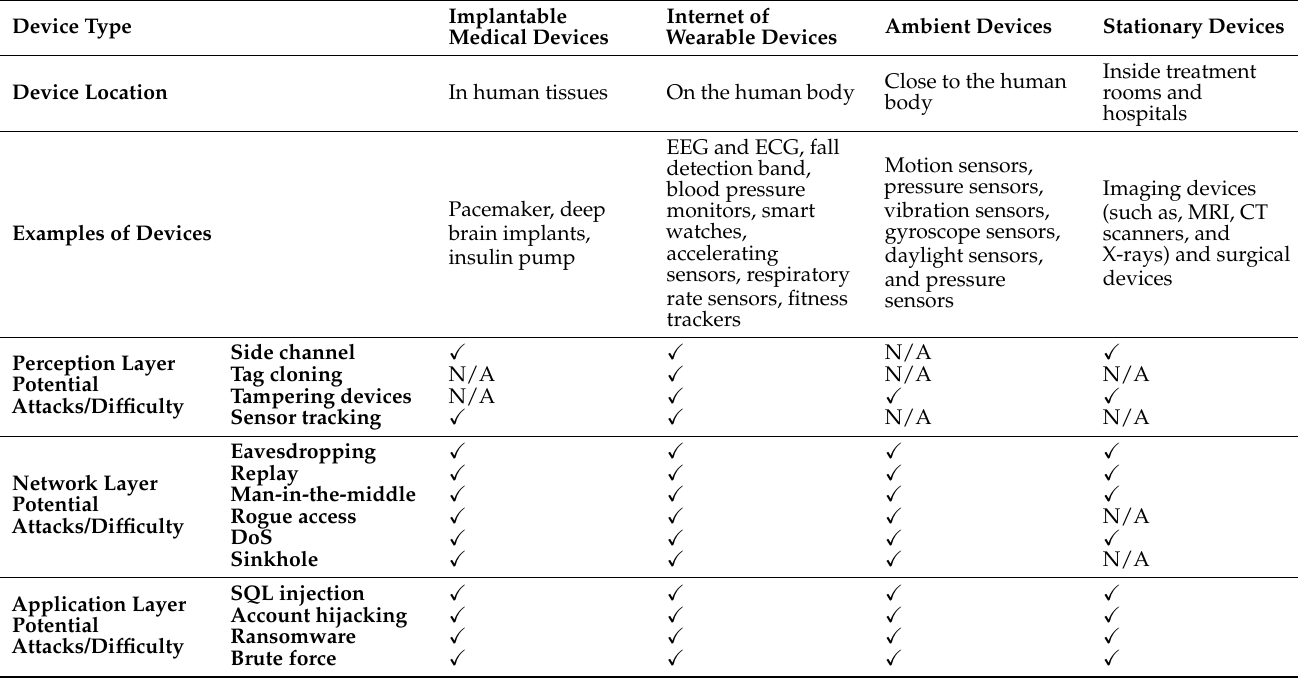
Table 4. IoMT device categories, their locations, examples for each category, and potential